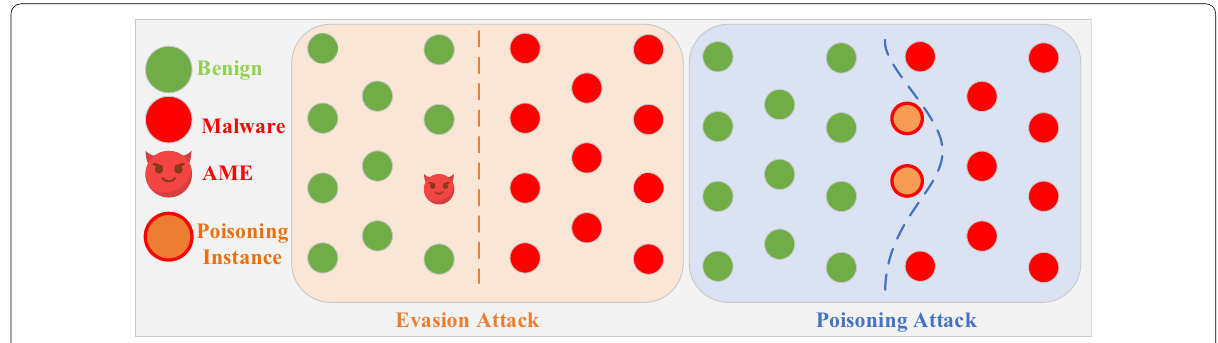
Fig. 2 Illustration of evasion attack and poisoning